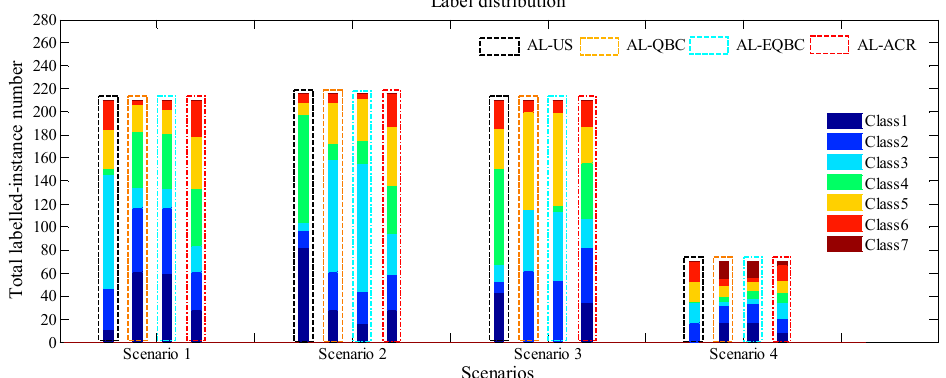
Figure 7. Label distribution in Scenarios 1–4.